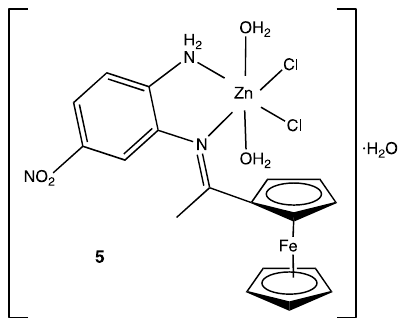
Figure 4. Structure of the Zn(II) complex against Streptococcus mutans [26].